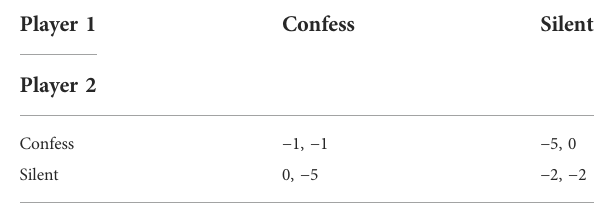
TABLE 1 Prisoners ’ game